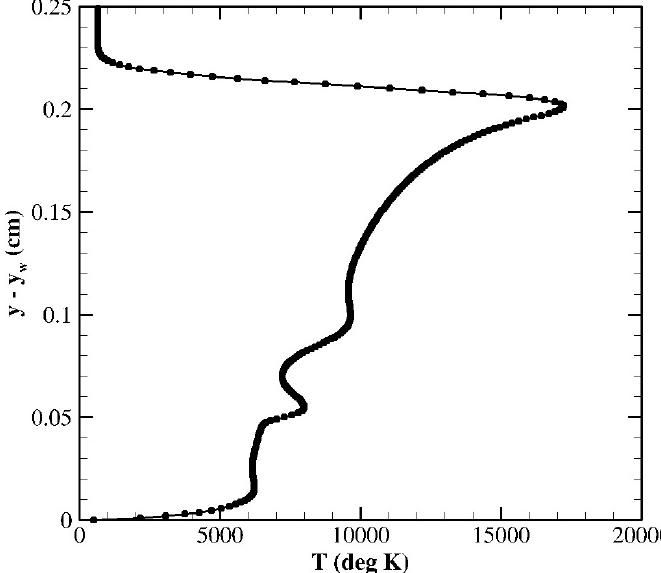
Figure 6. Static temperature for Run 4 (non-equilibrium Navier–Stokes) at x = 9.756